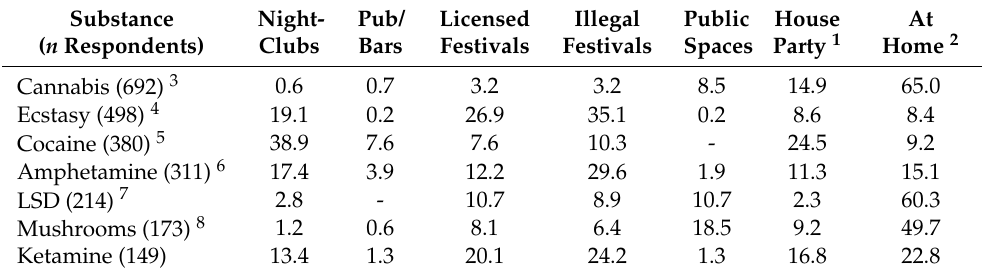
Table 3. Main setting of illicit drug use stated by drug users (% of